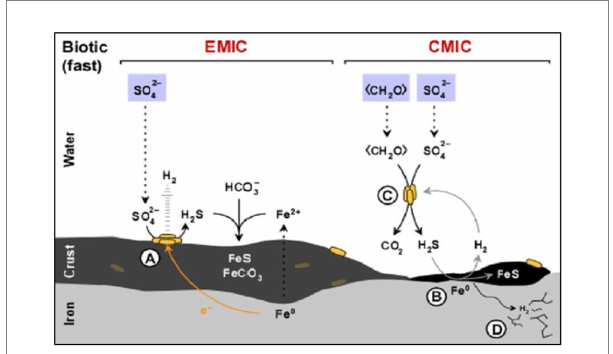
FIGURE 2 Diagram of the influence of sulfate-reducing bacteria (SRB) activity in the corrosion of iron. (A) Electrical microbially influenced corrosion (EMIC) mechanism. (B) Chemical microbially influenced corrosion (CMIC) mechanism. (C) Overall representation of CMIC. (D) Sulfide stress cracking. Modified from Enning and Garrelfs